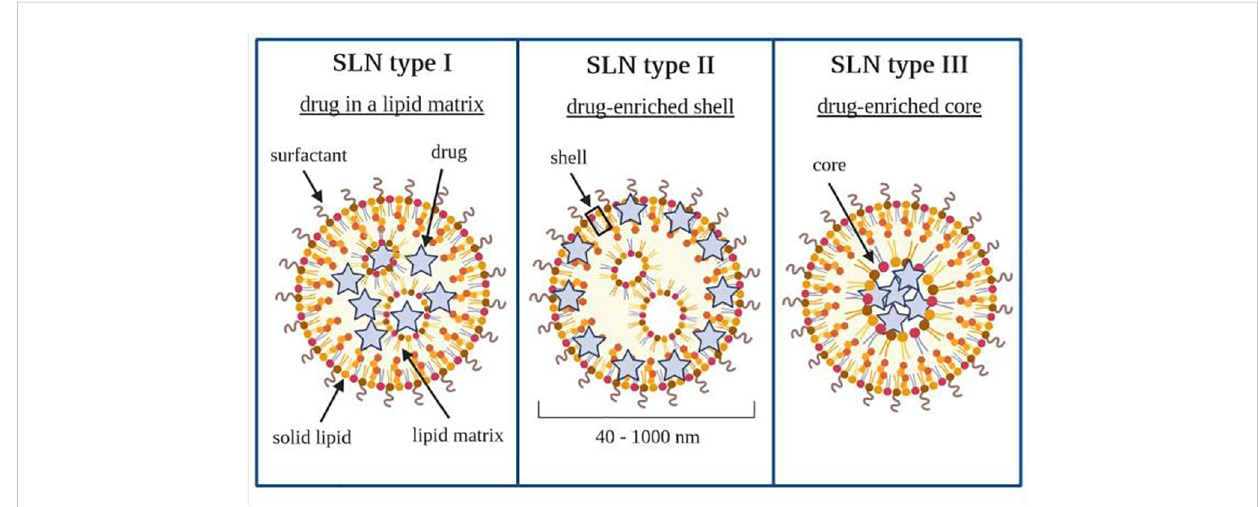
FIGURE 6 Types of solid lipid nanoparticles. Own drawing based on